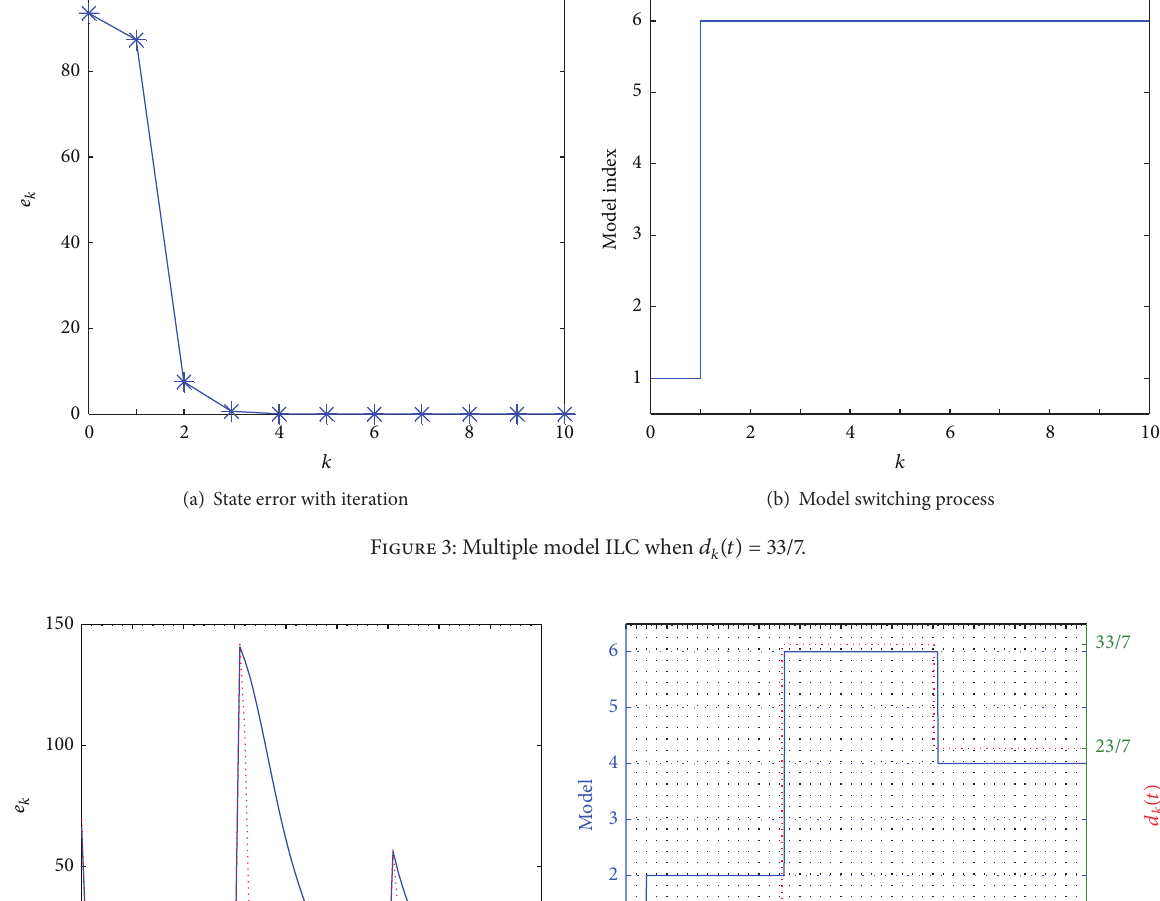
Figure 4: Control results of single and multiple model ILC dealing with plant with jumping